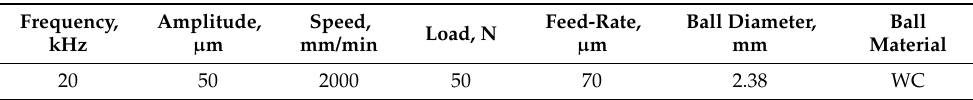
Figure 2. Schematic view of UNSM technology. Table 3. UNSM treatment parameters.